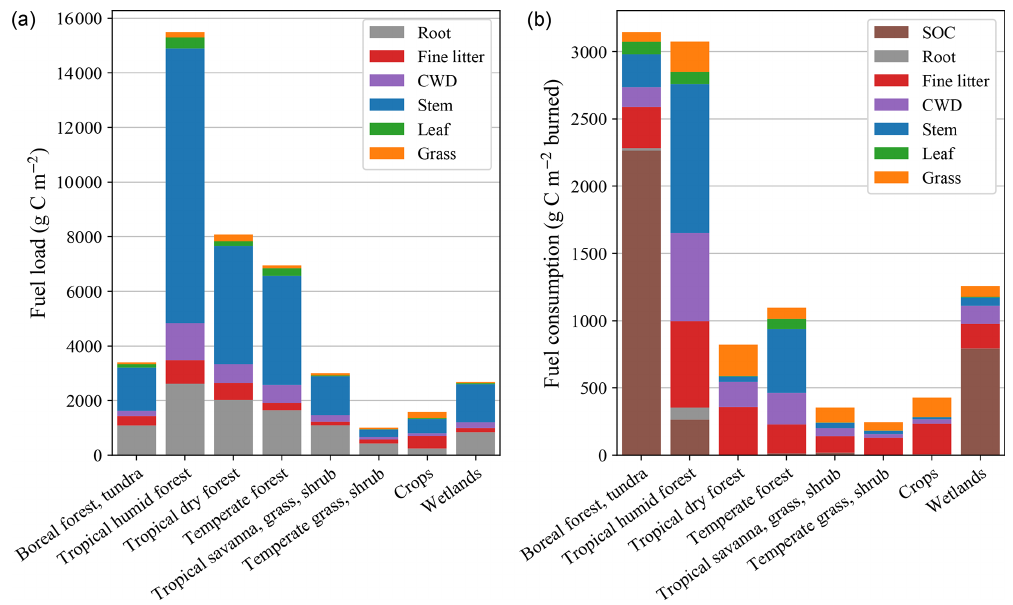
Figure 4. 2002–2020 average (a) fuel load and (b) fuel consumption per biome. Bars are subdivided in model biomass and litter pools. Because of the use of static SOC maps, panel (a) does not include soil organic carbon fuel